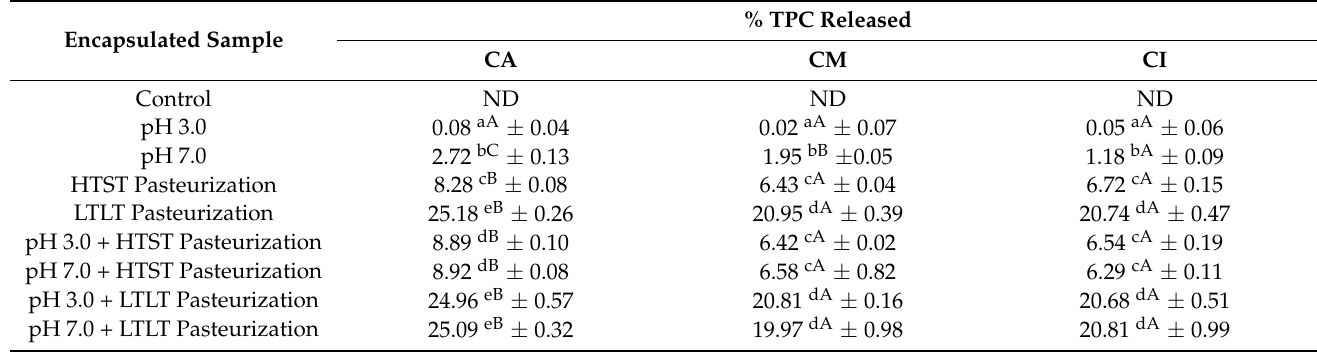
Table 5. % TPC release of alginate, alginate/maltodextrin, and alginate/inulin hydrogel beads containing encapsulated antioxidant crude extract from CSCG after passing through the simulated food process conditions.